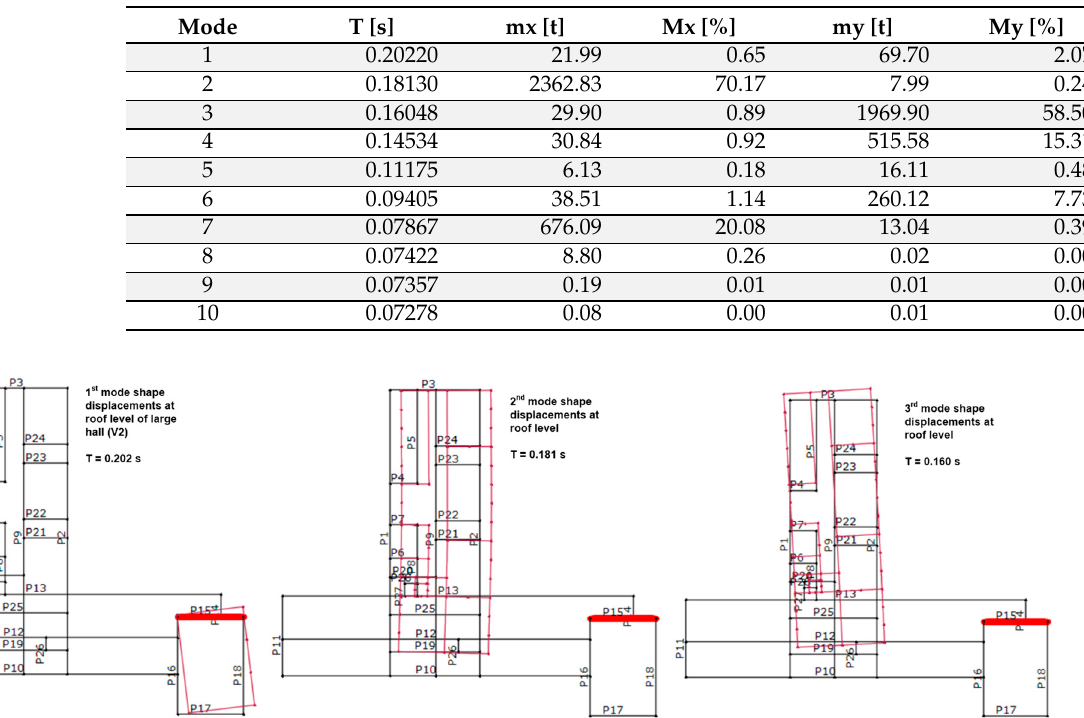
Table 4. Eigenmode periods obtained by EFM for the retrofitted structure.